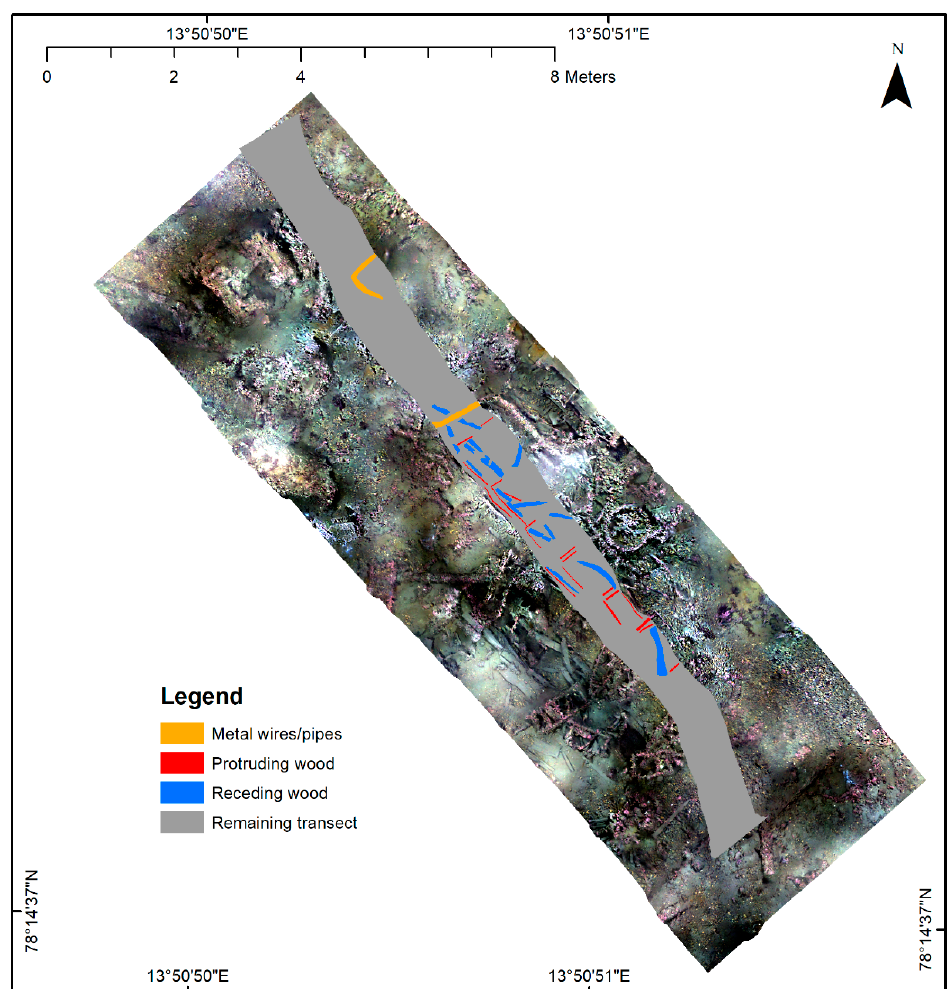
Figure 1. Regions of interest (ROIs) corresponding to different marine archaeological substrate types in the analyzed underwater hyperspectral imaging (UHI) transect from the Figaro wreck site. The background image is a contrast-enhanced subset of the Figaro orthophoto. The figure was generated in ArcMap (v. 10.6; Esri Inc., Redlands, USA; http://desktop.arcgis.com/en/arcmap/). Projection: UTM 33, Datum: WGS 1984.